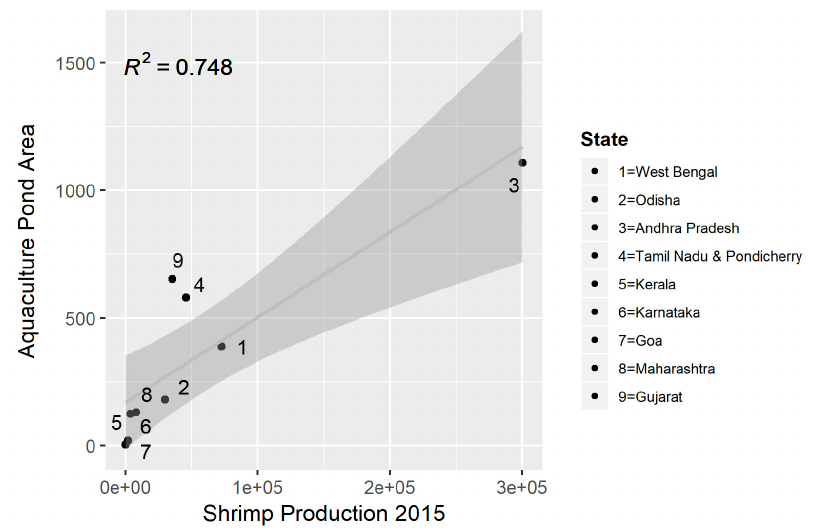
Figure 9. Province-wise aquaculture pond area calculated from the results of segmentation analysis.